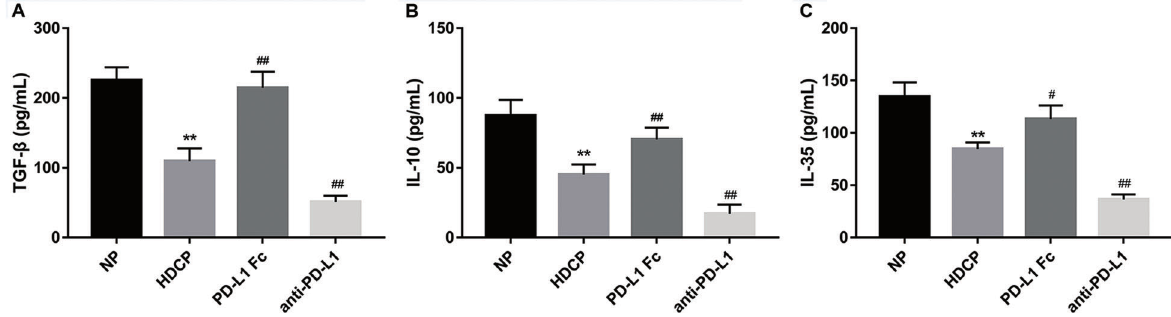
Figure 4. PD-L1 Fc elevated Treg-related cytokines. PD-L1 Fc (10 m g/mL) and anti-PD-L1 mAb (10 ng/mL) were added into the isolated peripheral blood mononuclear cells of women with normal pregnancies (NP) and hypertensive disorder complicating pregnancy (HDCP) and incubated for 3 days. A , TGF- b , B , IL-10, and C , IL-35 levels detected by ELISA. Data are reported as means ± SD. **P o 0.01 vs NP; # P o 0.05, ## P o 0.01 vs HDCP ( t